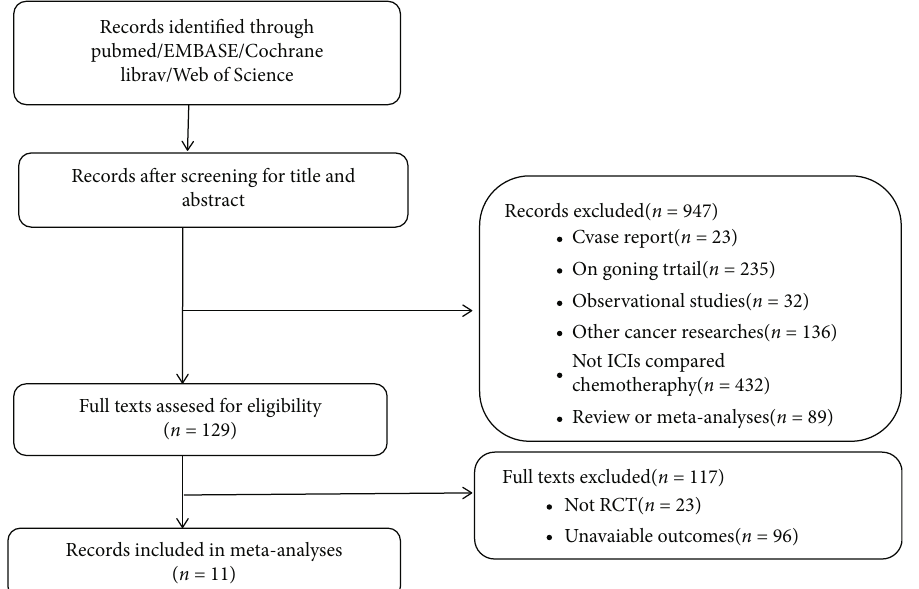
Figure 1: Flow chart of the literature